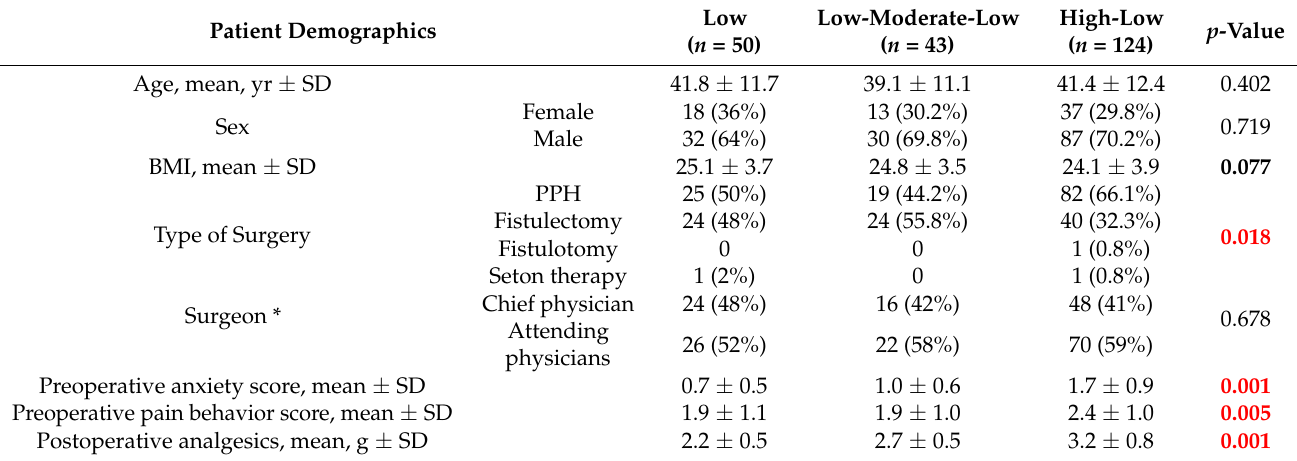
Table 3. Patient demographics by